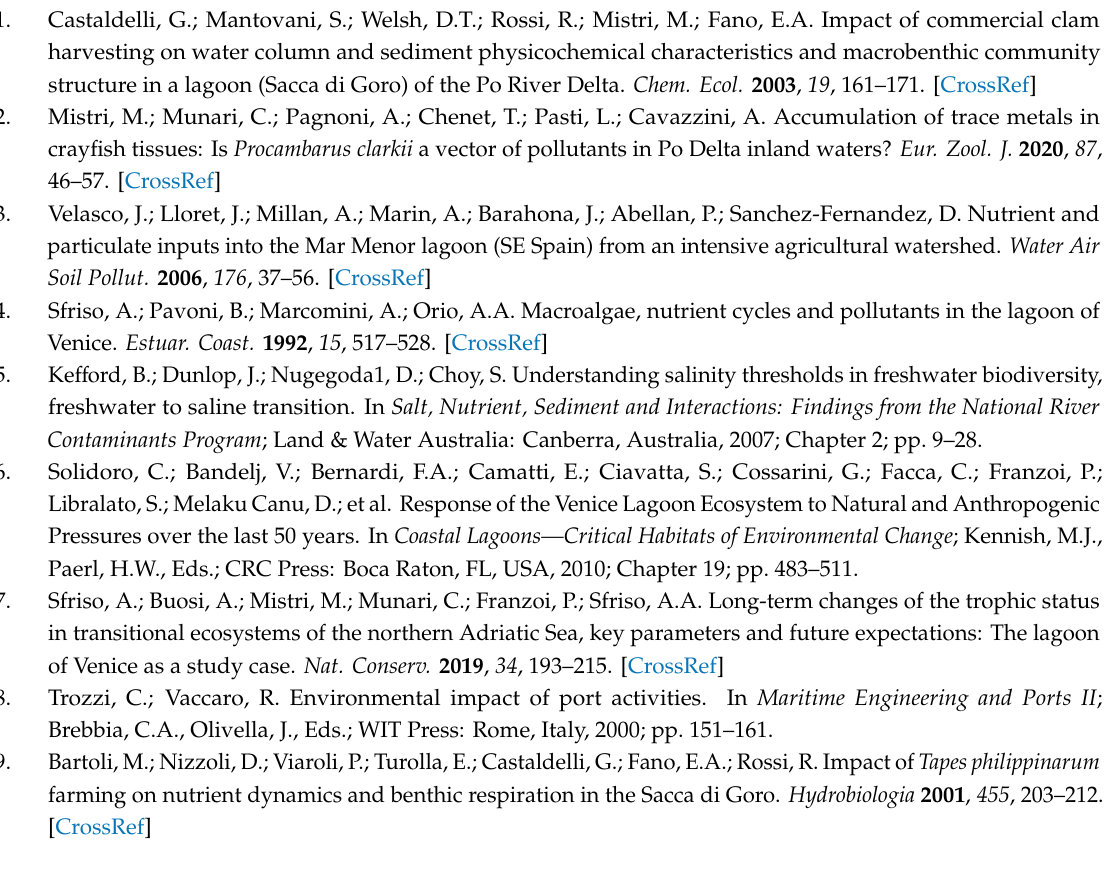
Table S1: Carbon concentrations in the lagoons and ponds of the North Western Adriatic Sea; Table S2: Sediment density and carbon concentrations in the Venice Lagoon during di ff erent scenarios: 2002, 2011, 2014, 2018; Table S3, Mean sediment density and carbon concentrations in the central Venice Lagoon during di ff erent